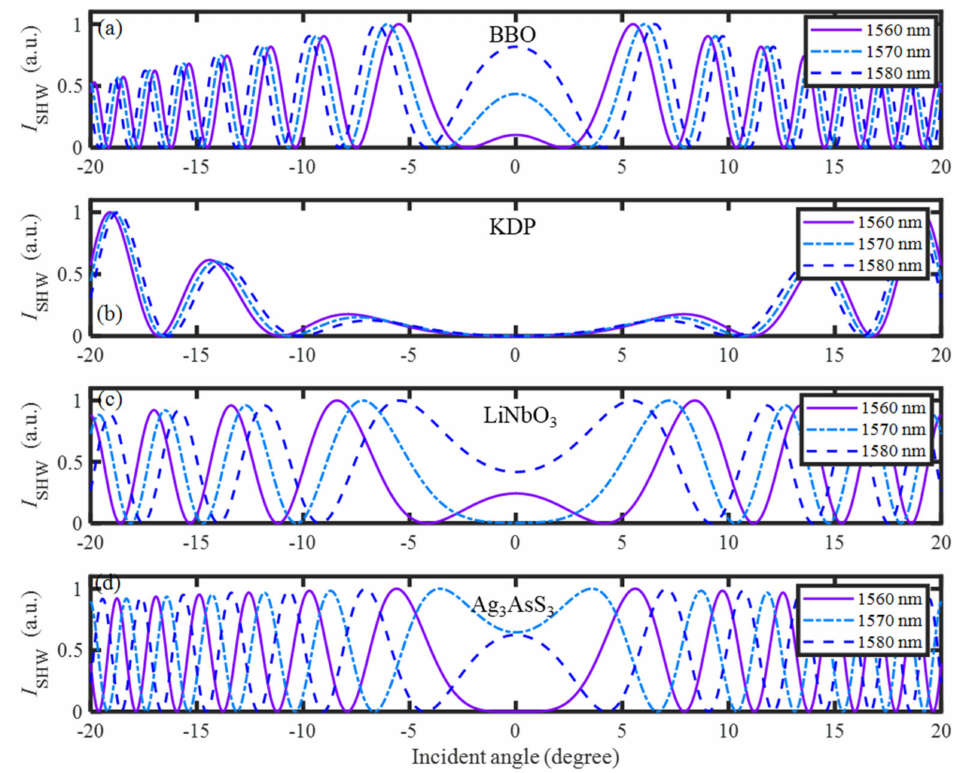
Figure 7. The dispersion of angle dependence. ( a ) BBO; ( b ) KDP; ( c ) LiNbO 3 ; ( d ) Ag 3 AsS 3